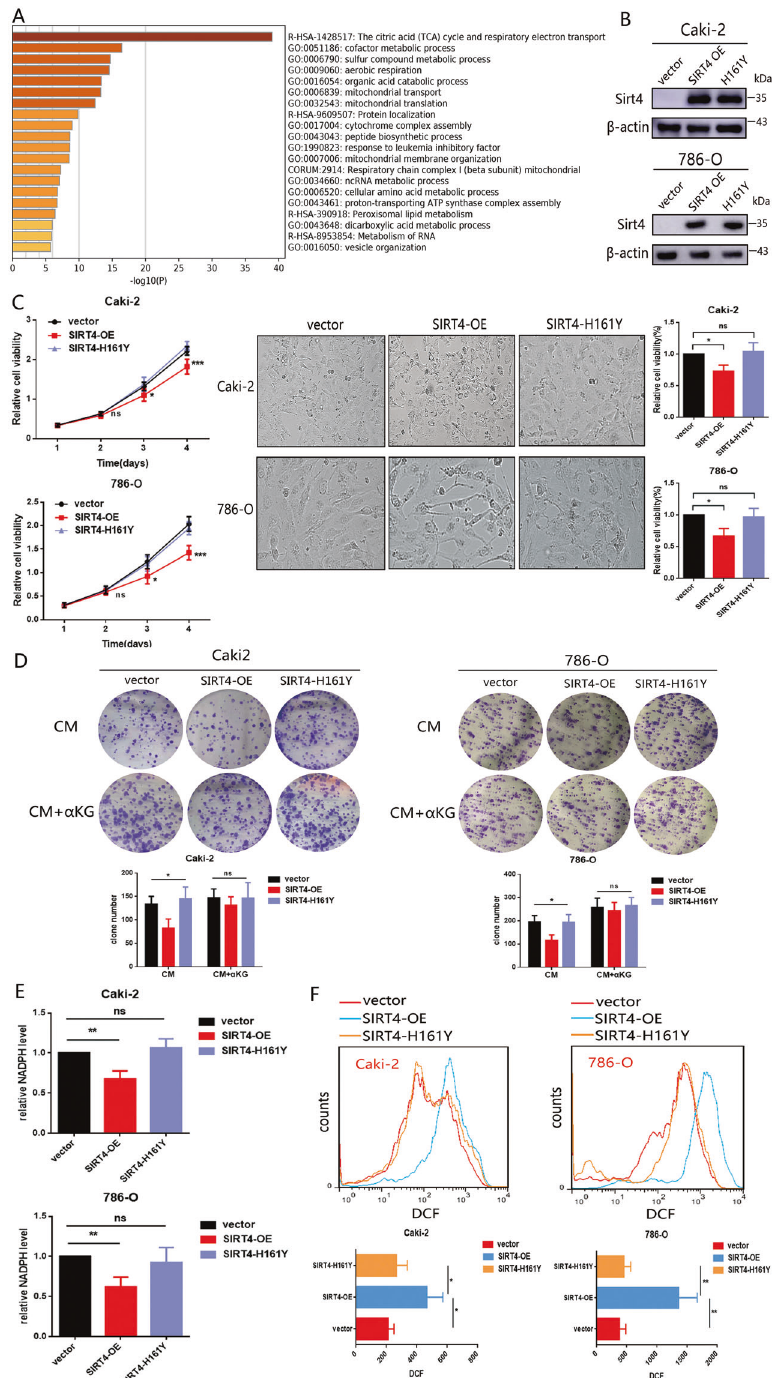
Fig. 3 SIRT4-OE restrained cell survival and enhanced intracellular ROS. A KEGG pathway enrichment analysis based on SIRT4 association genes was performed by Metascape . B The ef fi ciency of SIRT4 overexpression and SIRT4-H161Y reconstitution in Caki-2 and 786-O cells were validated by western blot. C Effects of SIRT4 or SIRT4-H161Y overexpression on cell growth was monitored by CCK8 (left panel) and representative phase-contrast photomicrograph (middle panel). The quanti fi cation analysis is shown as the right panel. D The effects of SIRT4- OE and H161Y reconstitution on colony formation capacity. Caki-2 and 786-O cells were cultured in a complete medium (CM) with or without supplemental α -KG (25 μ M). A summary of the quanti fi cation analysis is shown underneath. E NADPH levels in cells with SIRT4 overexpression and H161Y reconstitution. F Intracellular ROS monitored by the DCFH-DA fl uorescent probe (DCF) via FACS. Data are expressed as mean ± SD, experiments were done in three independent times. Throughout the fi gure, * P < 0.05, ** P < 0.01, ns: no signi fi cance.